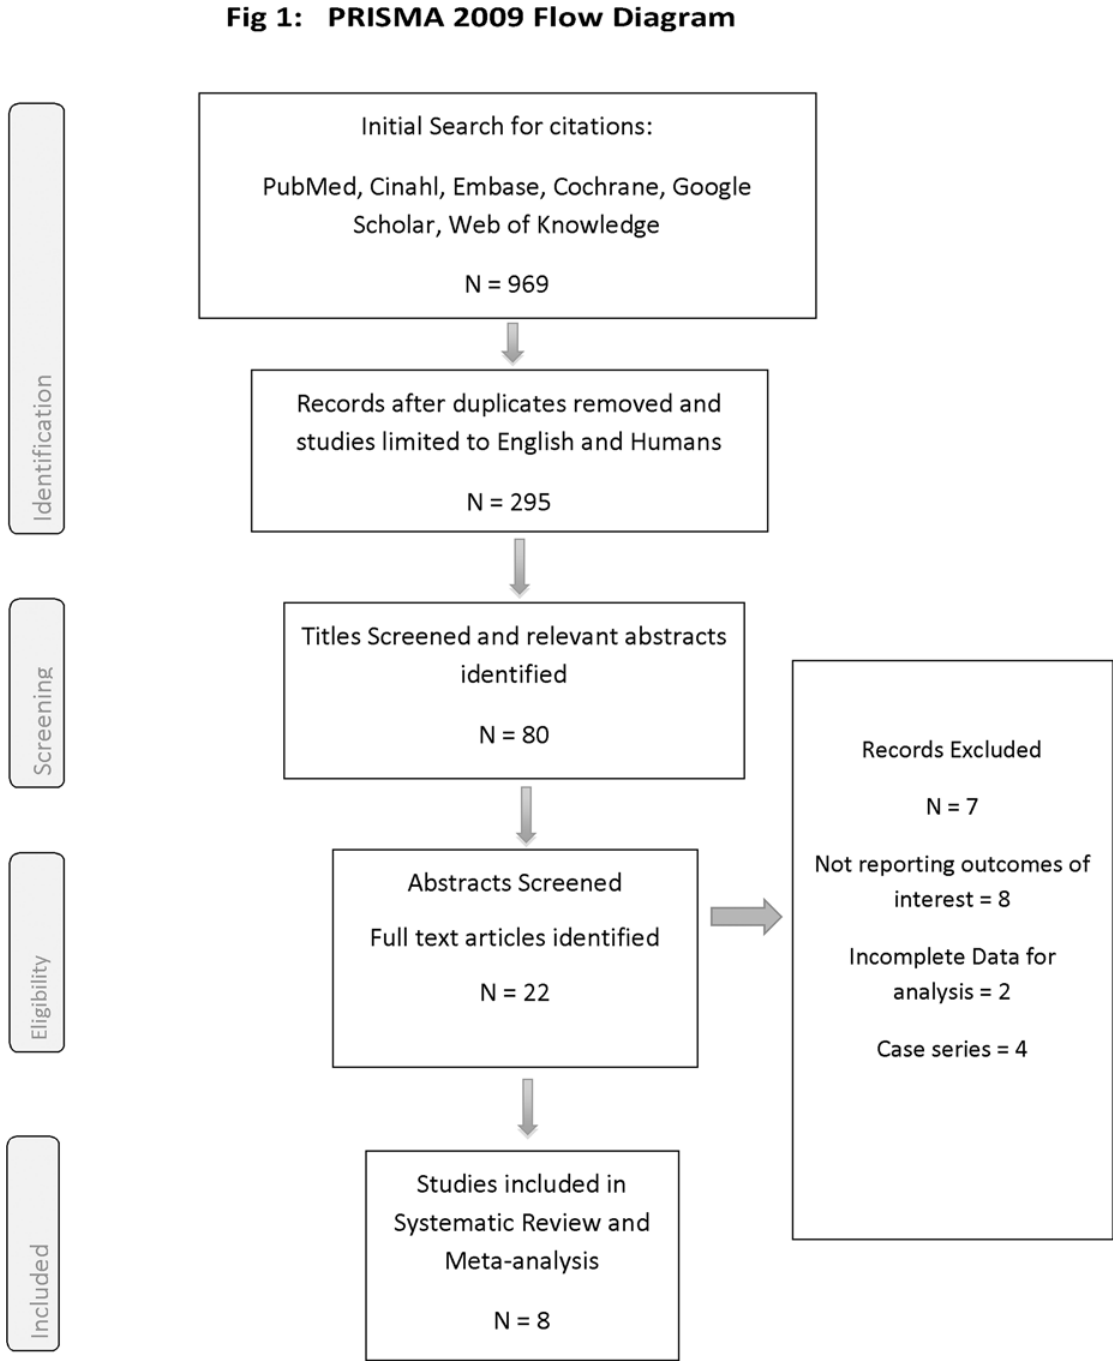
Fig 1. Prisma Flow Diagram. Eligibility for inclusion was determined by two researchers separately (KB, DH) by going through the abstracts of the relevant citations. Differences were settled by examining the full article by both authors, and then any remaining uncertainties regarding eligibility of studies were settled following a discussion with a third author